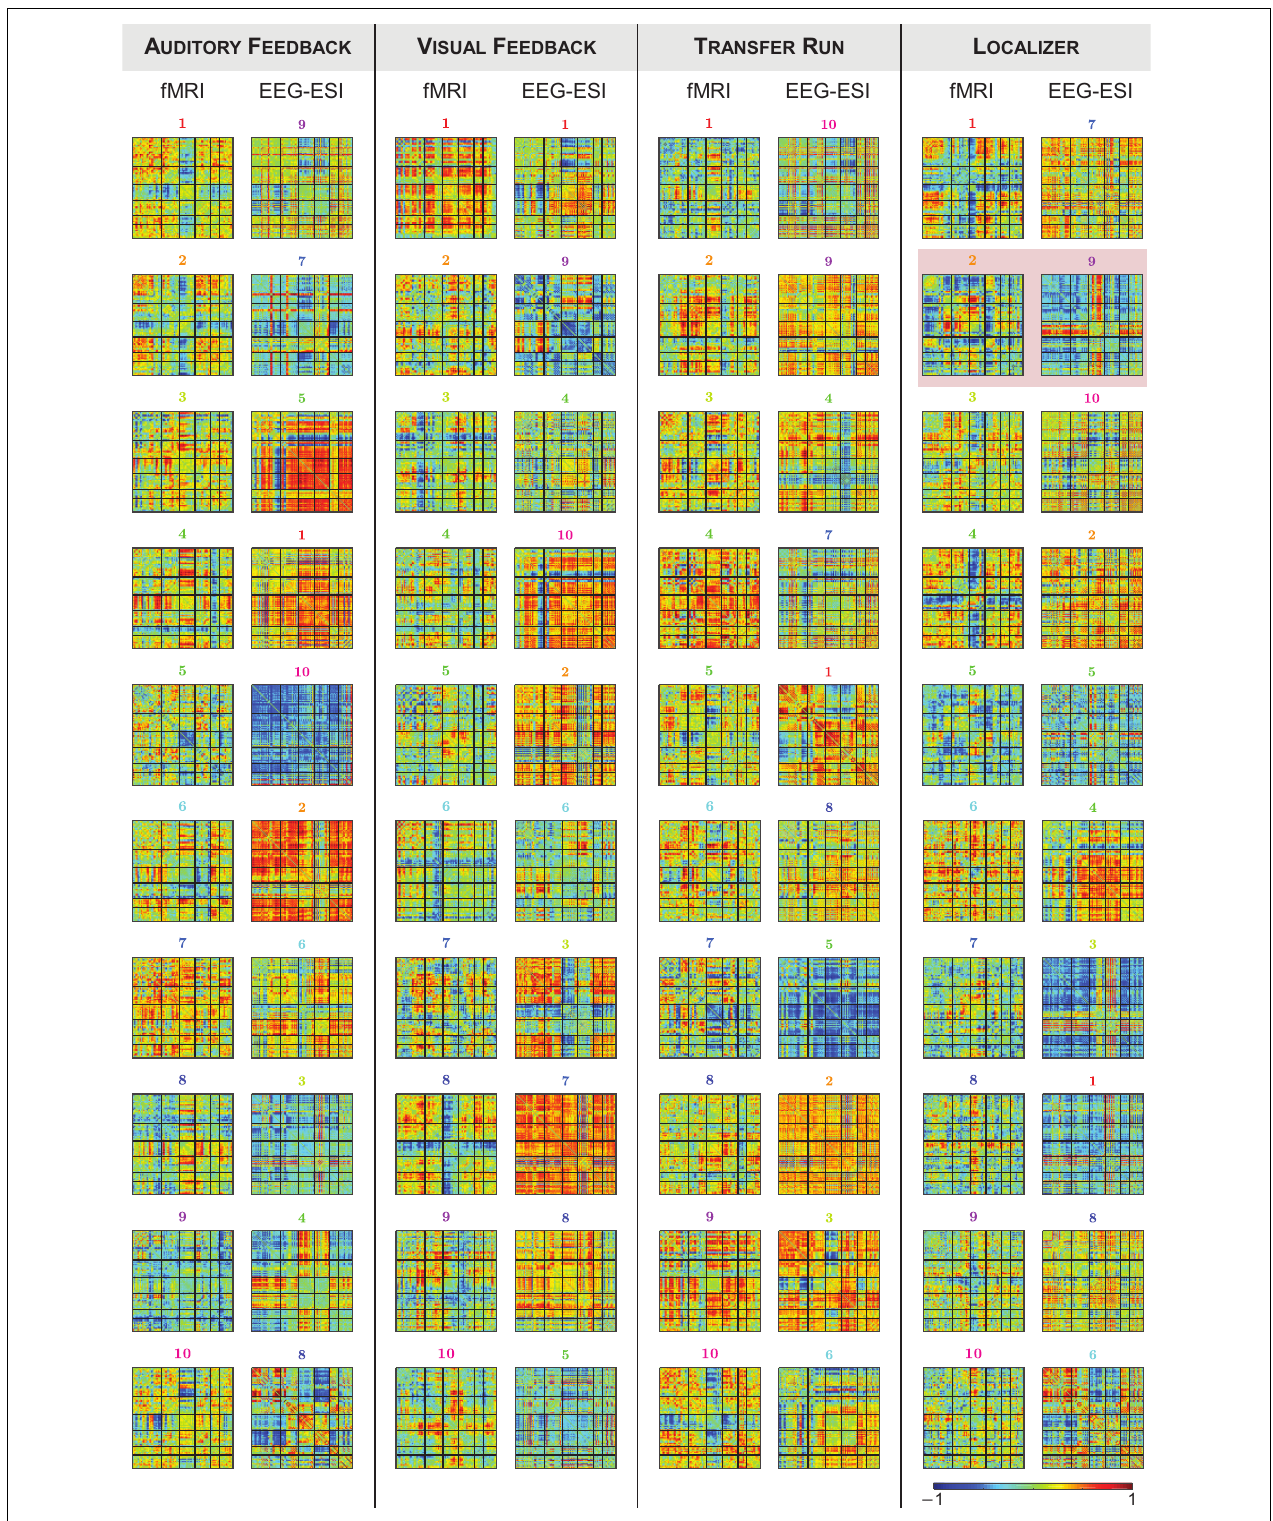
FIGURE 4 | Group dFC states estimated from fMRI and EEG-ESI data for the (from left to right) auditory feedback, visual feedback, transfer, and localizer runs. For each run, the correlation matrices (normalized between –1 and 1, for visualization purposes) of the dFC states estimated from the fMRI data (left) and the matched EEG-ESI dFC states (right) are shown. For the localizer run, fMRI state #2 and EEG-ESI state #9 are highlighted by the red square, as these two matched dFC states were associated with the activity at the FEPN.